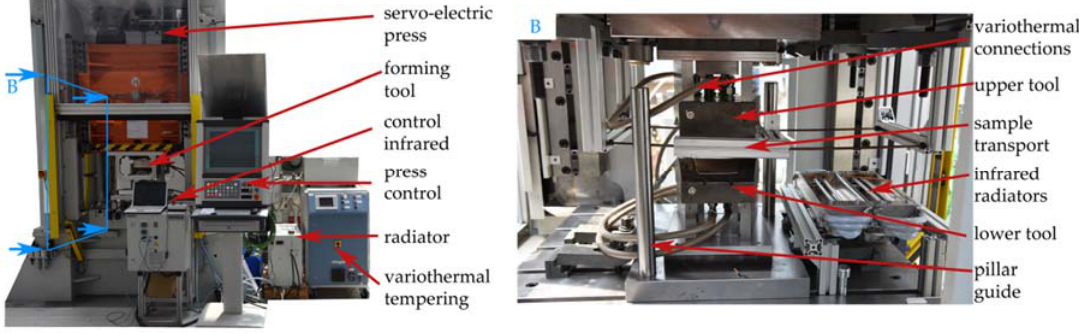
Figure 3. Variothermal forming tool in a servo ‐ electric press and a detailed side view